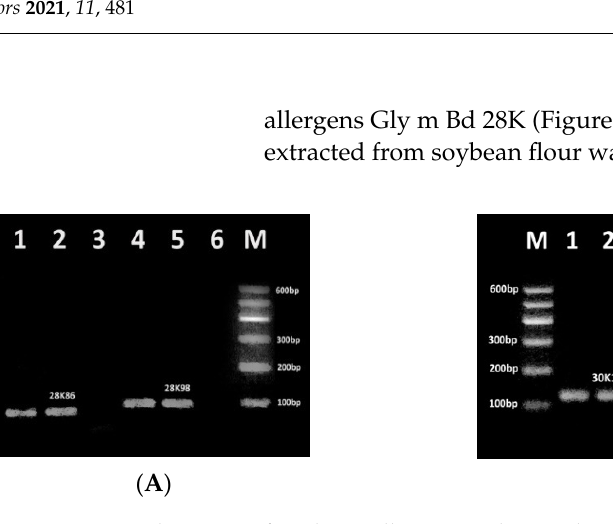
Figure 1. PCR detection of soybean allergens: Gly m Bd 28K using primer pairs 28K86f/28K86r ( A , lanes 1–3) and 28K98f/28K98r ( A , lanes 4–6), Gly m Bd 30K using primer pairs 30K122f/30K122r ( B , lanes 1–3), 30K129f/30K129r ( B , lanes 4–6), 30K118f/30K118r ( C , lanes, 1–3). Samples: lanes 1–2, 4–5. soybean seeds flour, lanes 3, 6. water (negative control). M . Molecular weight marker (Qiagen GelPilot 100 bp ladder).